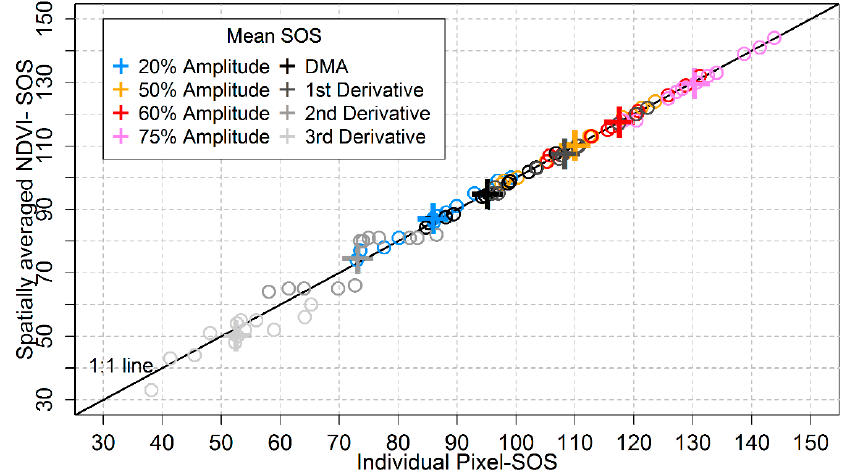
Figure 8. Comparison of LSP-SOS time series (day of year) obtained from spatially or regionally averaged NDVI for the broadleaf pixels in the study area (y-axis) and SOS averaged from single/individual pixels SOS (x-axis). Note: SOS time series as coloured unfilled circles and its mean as coloured crosses.